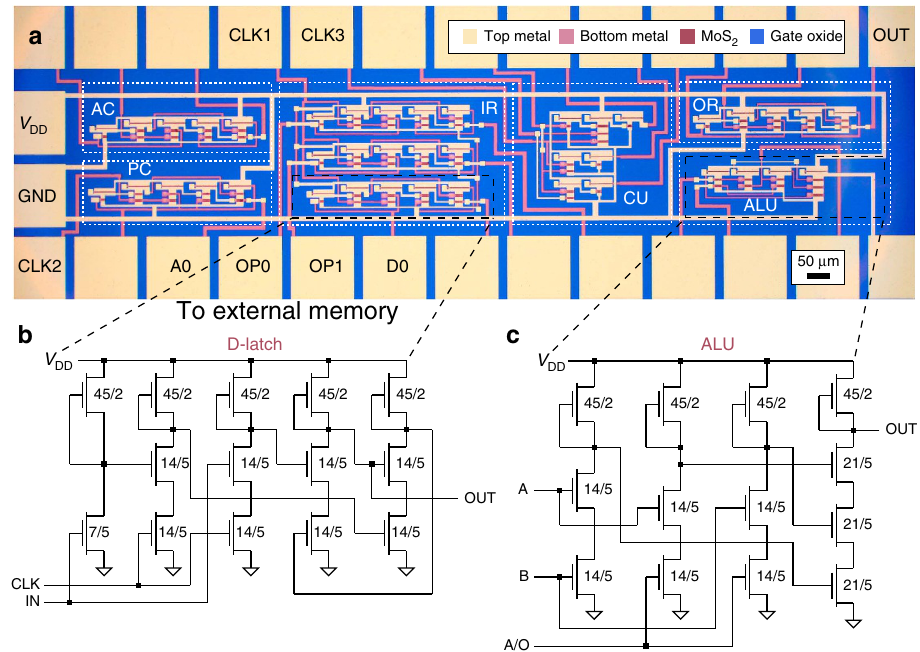
Figure 3 | Device implementation using a 2D semiconductor. ( a ) Microscope image of the microprocessor. The two metal layers appear in different colour and are connected with via-holes. All subunits were provided with metal pads for individual testing. Labelled pads were used to connect the device to the periphery (memory, CLK signal generation, power supply, output), the others were wire bonded together to realize the internal connections. Scale bar, 50 m m. Circuit schematics of ( b ) D-Latch and ( c ) ALU, with W / L ratio in units of m m/ m m for each transistor. IN, input; OUT, output. The complete microprocessor schematic is presented in Supplementary Fig.